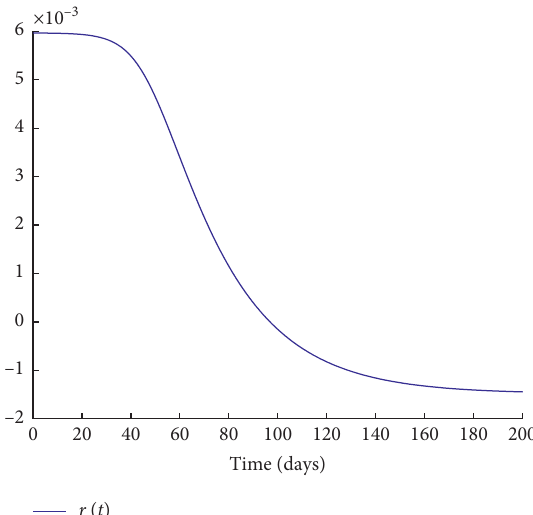
Figure 2: Number of active cases per day obtained from the SIR model and from reported data.